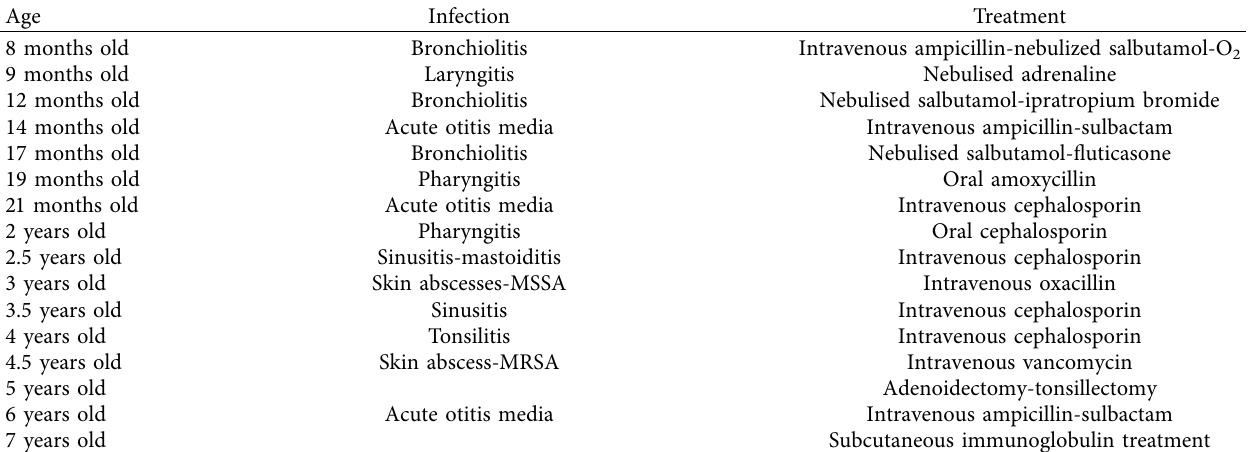
Table 1: Summary of the patient’s infections and therapy.